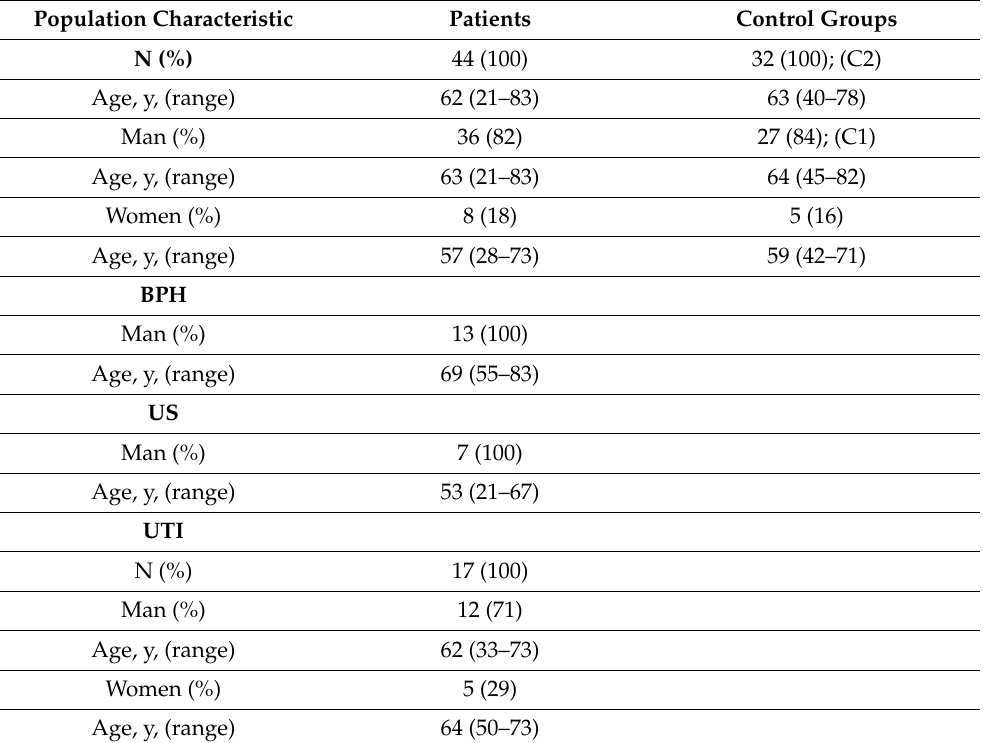
Table 1. Demographic and clinical data of patients and the control